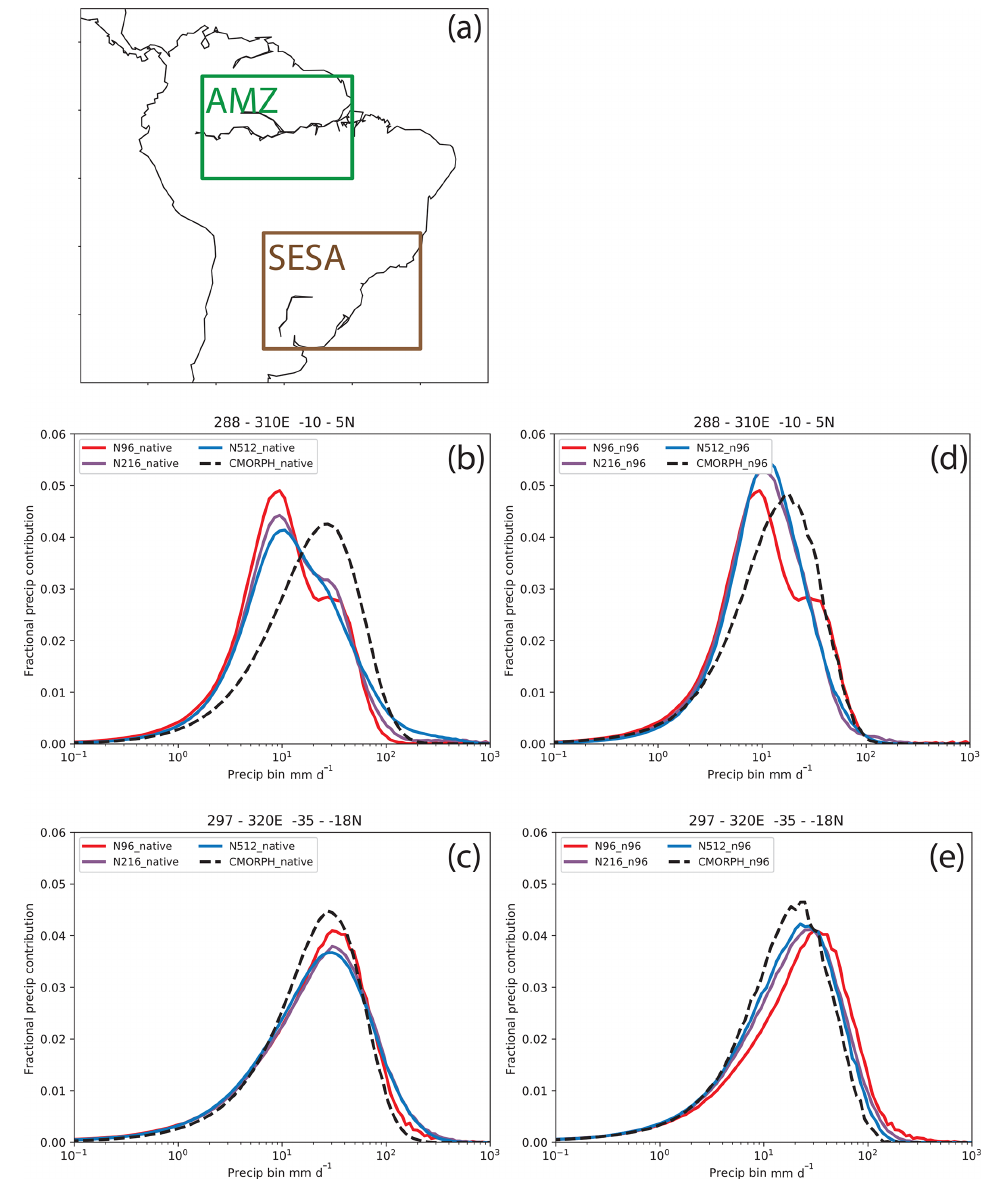
Figure 12. (a) Subregions used in our study: (i) the Amazon region (AMZ; green box; 10 ◦ S–5 ◦ N, 72–50 ◦ W) and (ii) the southeast South America region (SESA; brown box; 35–18 ◦ S, 63–40 ◦ W). Histograms of the average precipitation contributions to the total precipitation from each precipitation bin for CMORPH and all simulations on their native grids for (b) AMZ and (c) SESA. Panels (d) – (e) are the same as (b) – (c) but at N96